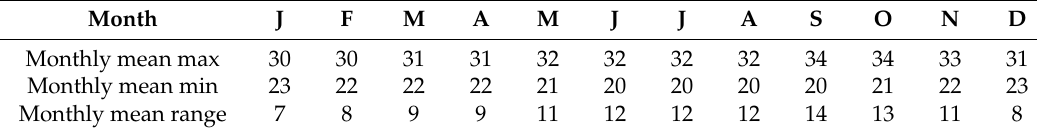
Table 5. Monthly mean air temperature ( ◦ C).